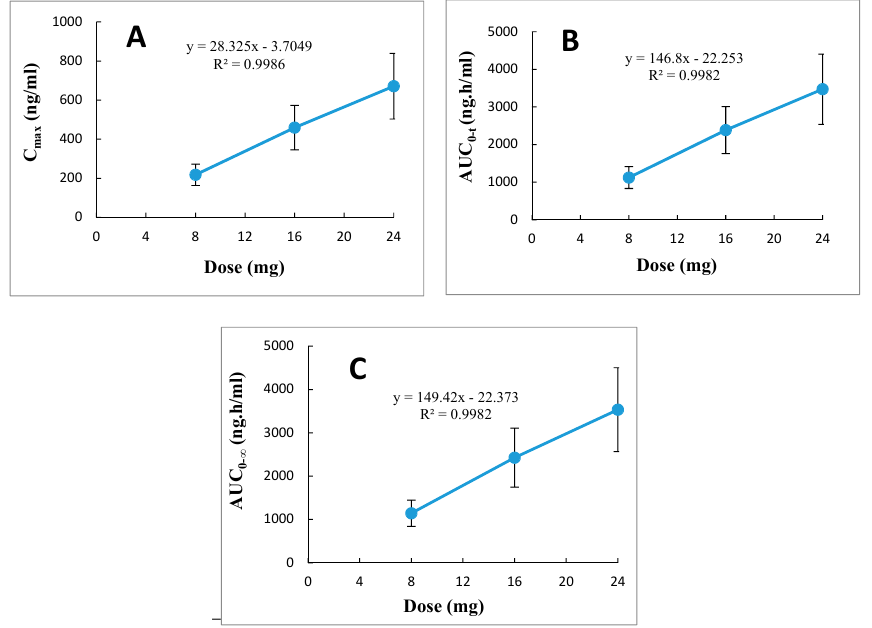
Figure 4. Dose proportionality of C max ( A ), AUC 0–t ( B ) and AUC 0– ∞ ( C ) with dose 8, 16, and 24 mg betahistine, mean ± SD.